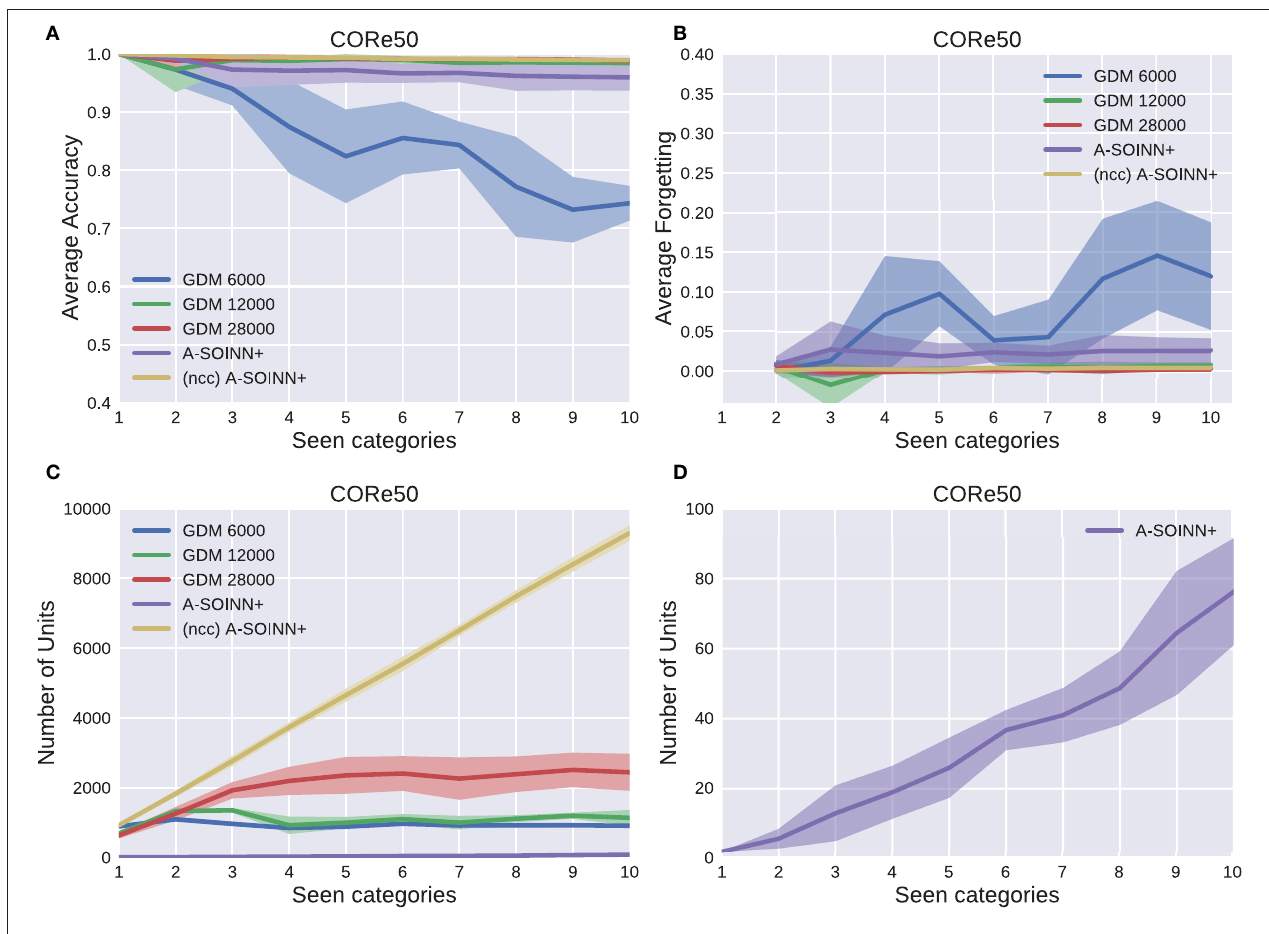
FIGURE 9 | The results of the fifth experiment, using the CORe50 dataset. For further descriptions, see Figure 5 .